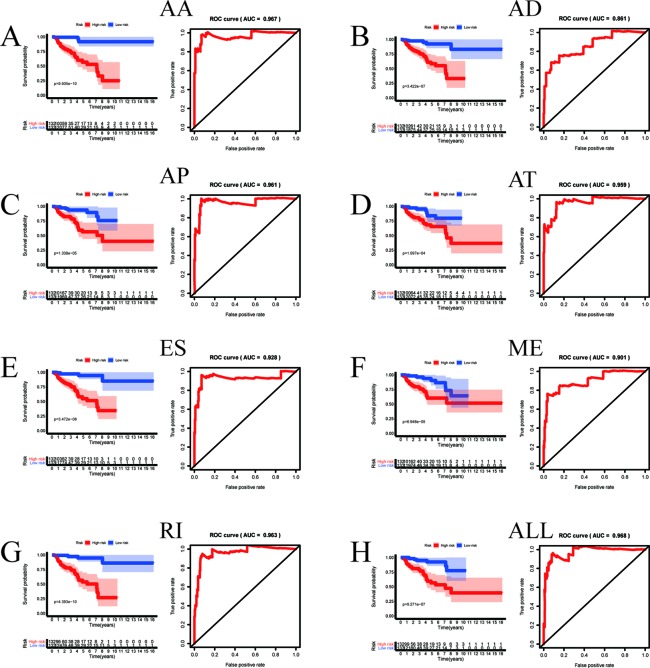
The prognostic value of PI presented by overall survival (OS) and ROC curves. Kaplan-Meier plot depicting the survival probability over time for prognostic predictor of seven types of AS events (A–G) and all AS event (H) with high (red) and low (blue) risk group, respectively. The ROC curve to which the respective model belongs is located to the right of the KM curve.